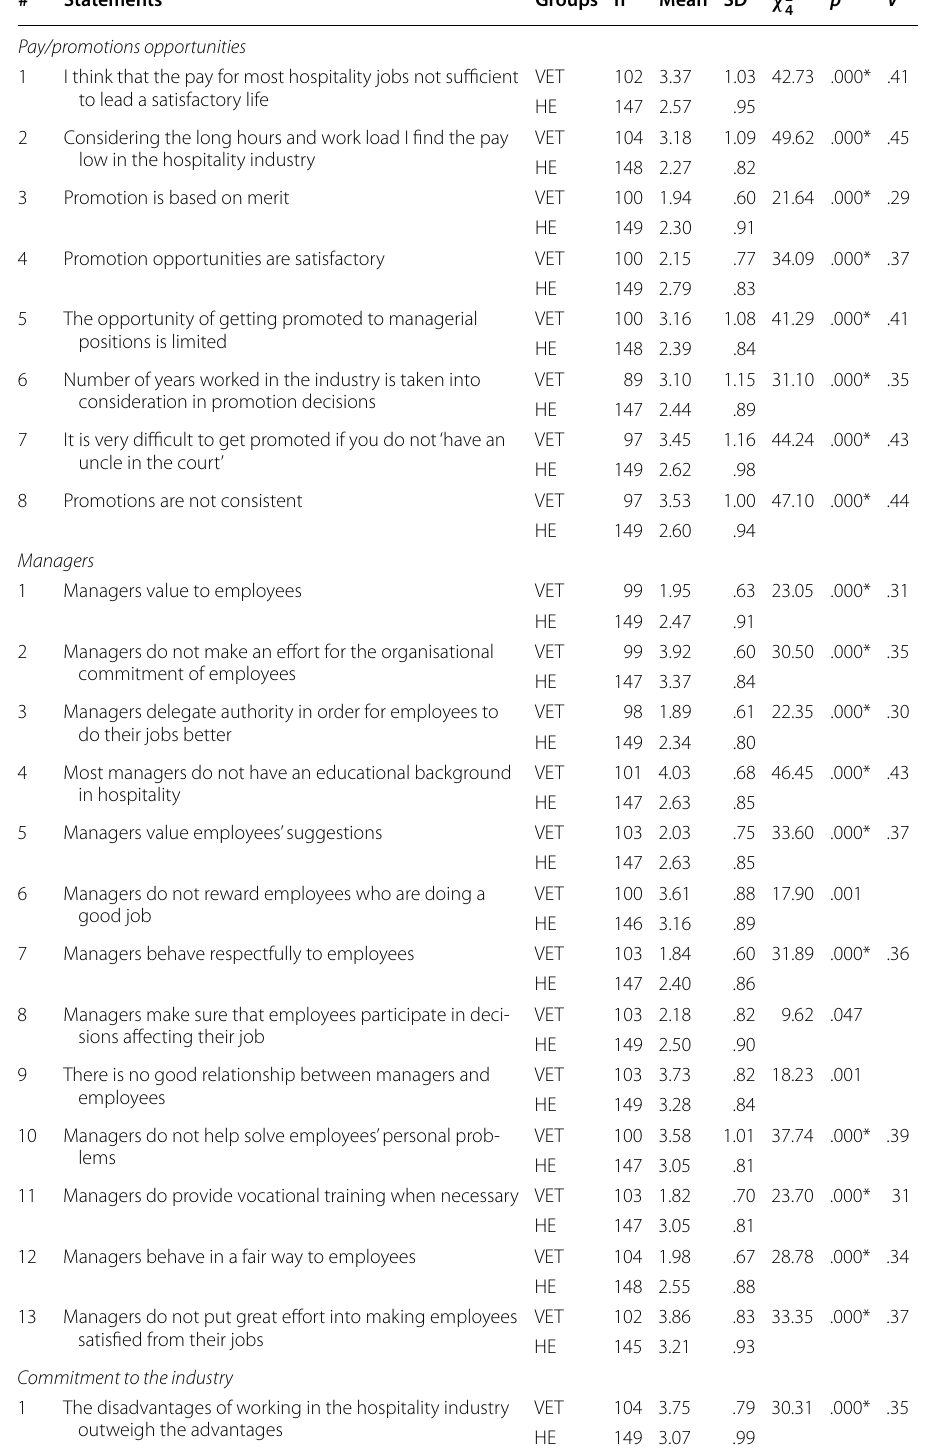
Table 5 Summary of survey responses to three dimensions, showing average agreement (from 1: strongly agree, to 5: strongly disagree) across seven dimensions by student